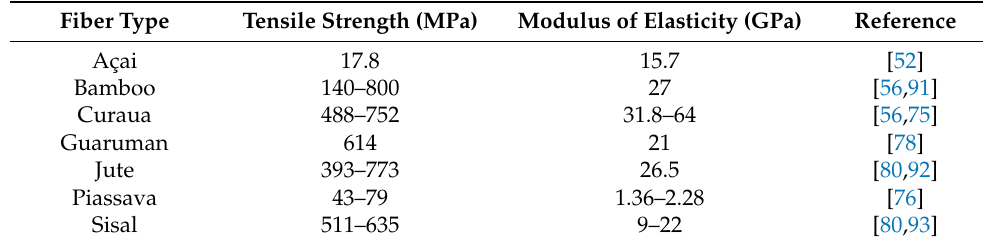
Table 3. Mechanical properties of Amazonian